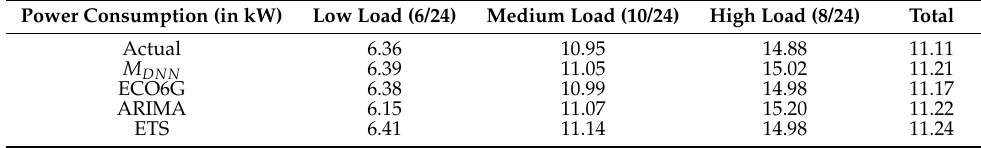
Table 4. Energy consumption for a typical